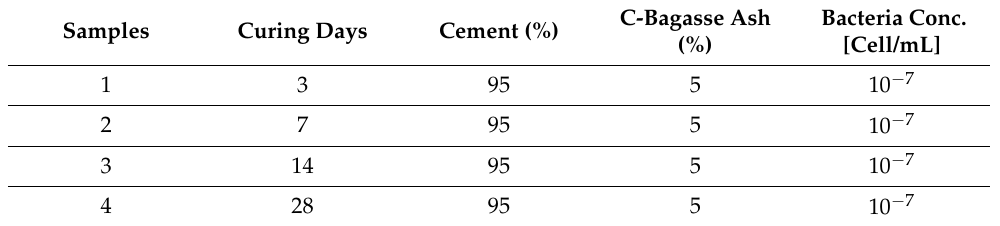
Table 1. Mixing proportions mortar samples with 1% calcium lactate [W/(Cement + BA) ≈ 0.53]. Samples